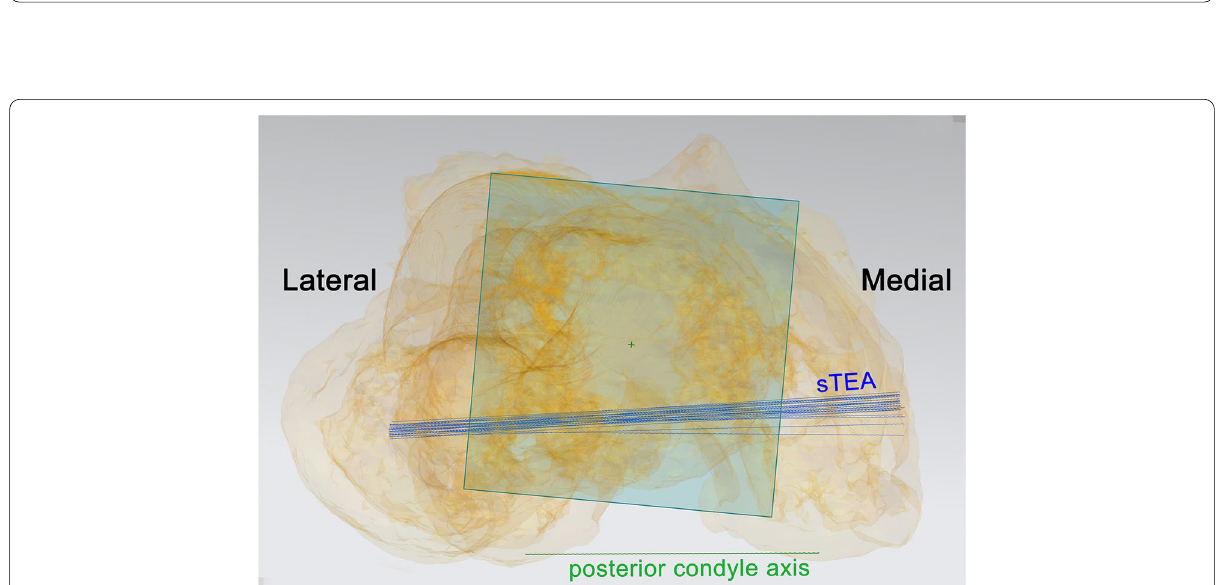
Fig. 2 Eighteen surgical transepicondylar axes and one posterior condyle axis are marked on 3D knee